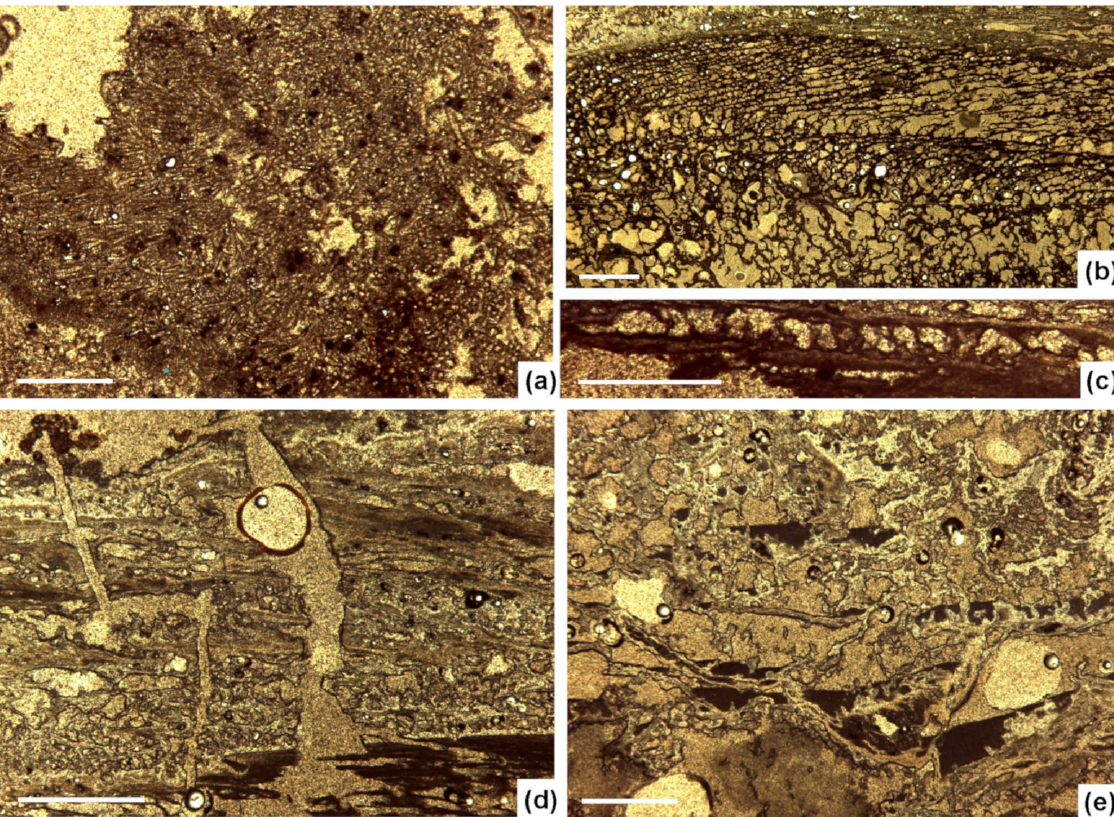
Figure 6. Thin-section photomicrographs of Selt ú n sinter exhibiting 2D porosities in transmitted plane light. ( a ) Meshwork of chaotically arranged microbial filaments encased in a primary fenestral pore. ( b ) Upward modification of ellipsoidal-to- laminoid fenestral pores in the onlapping microbial packages shown in Figure 6a. ( c ) Detail of fenestral pores separating two microbial laminae mimicking hourglass structures [19]. ( d ) Network of vertical pores (up to 500 µ m in size) connecting fenestral (laminoid-dominant) pores, probably reflecting upward escape of gas bubbles in a partly indurated sediment. ( e ) Laminoid fenestral pores showing geopetal sediment floors composed of zeolite/clay mixtures; scale bars = 2 mm (for Figure 6a,e) and 1 mm (for Figure